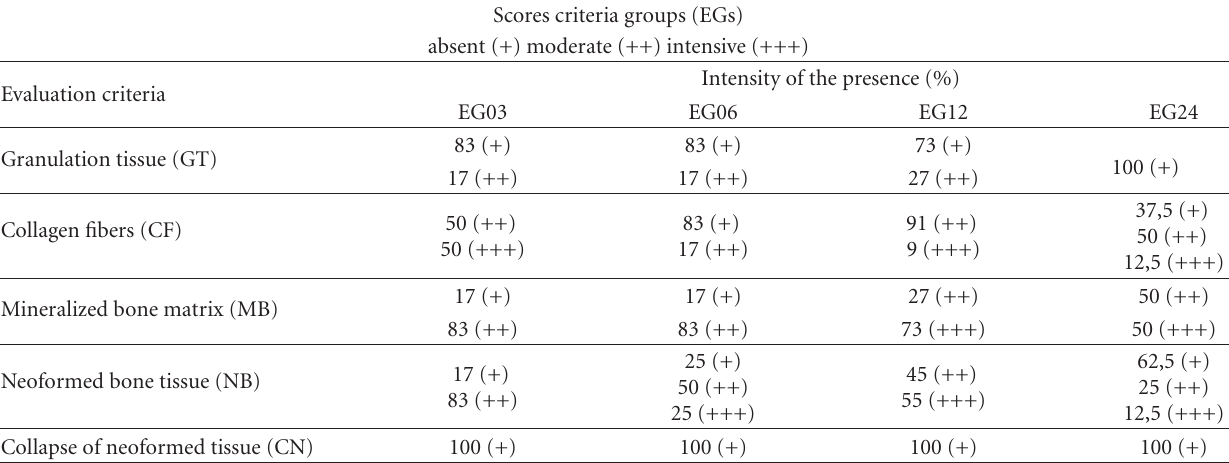
Table 2: Percentage of the results according to criteria and attributed the